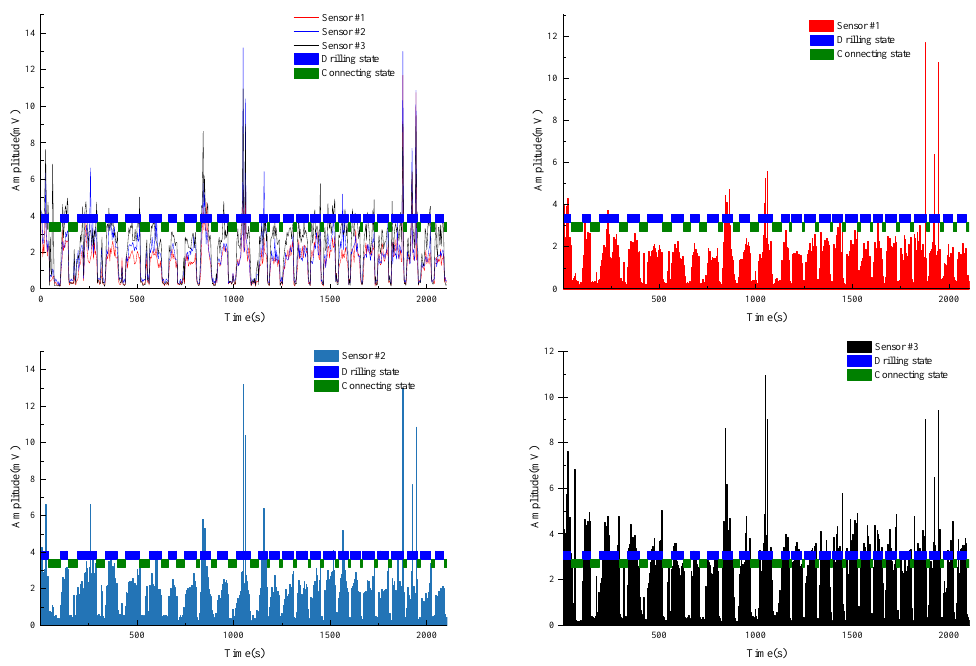
Figure 12. Test#4 drilling state final identification results.